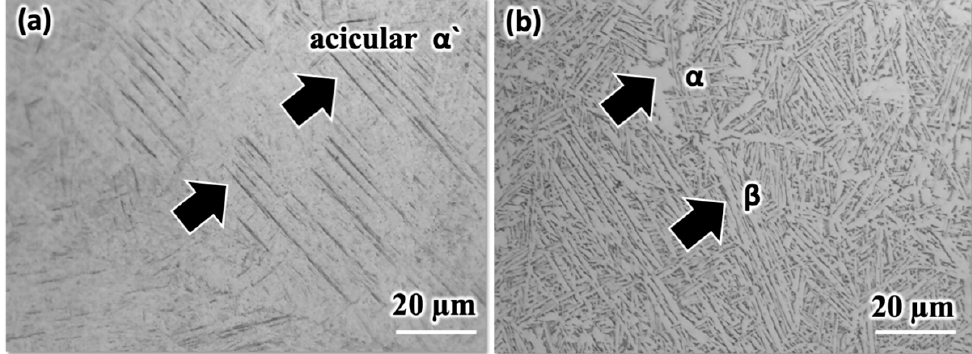
Figure 7. Representative optical micrographs of the Ti-6Al-4V ELI alloy samples: ( a ) ASR and ( b ) HIP.